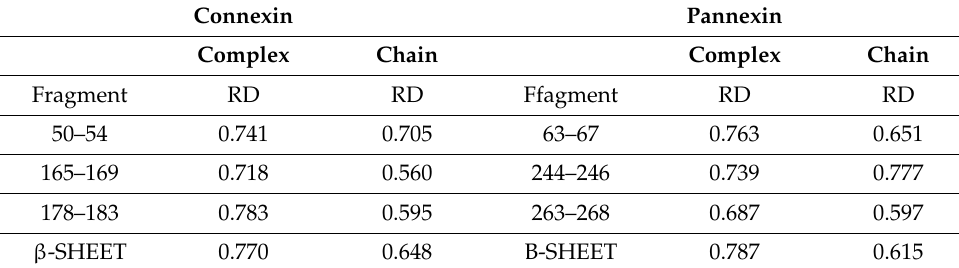
Table 4. Status of the beta-structure segments and the entire beta-sheet in the two compared